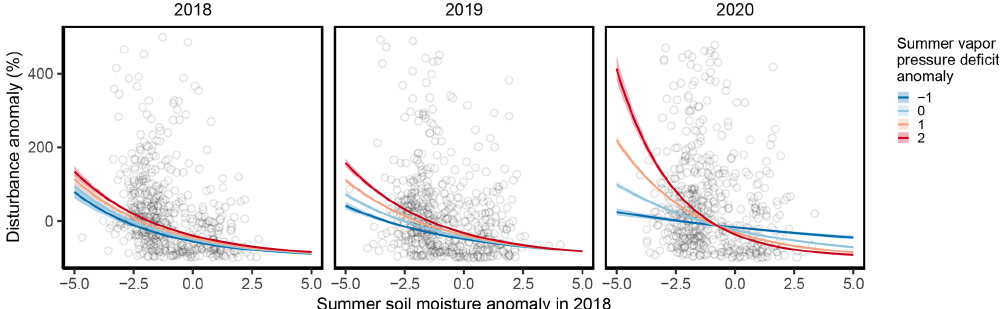
Figure 2. Relationship between forest disturbance anomaly in 2018, 2019, and 2020 (see Fig. 1) in relation to local summer (June, July, and August) soil moisture (SM) anomaly in 2018 and summer vapor pressure deficit (VPD) anomalies in the respective years. All anomalies are expressed relative to the period 1986–2015. The black dots show a sample (1%) of the raw data. Ribbons around solid lines indicate the 95% confidence interval. Note that disturbance anomalies were capped at + 500 to improve visibility. A more detailed version of this figure is available as Fig. S1 in the Supplement.